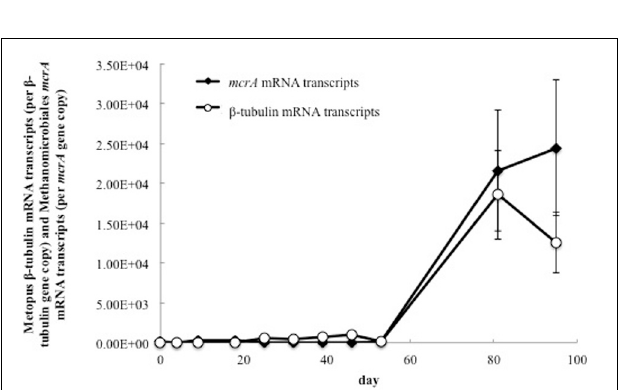
FIGURE 3 | Relative abundance of mcrA mRNA transcripts from methanogens associated with groundwater collected on day 53 when acetate concentrations were 6.71mM and day 95 when acetate concentrations were below detection.